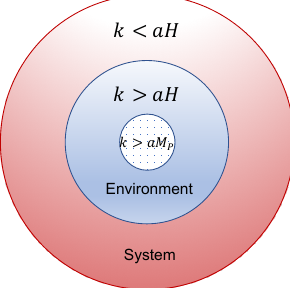
Figure 1. Schematic illustration of the system and environment modes for this setup. Gravity plays the role of providing a natural scale — the comoving Hubble horizon — which demarcates “long” and “short” degrees of freedom (dofs). We impose the Planck mass as the natural cutoff for the UV-modes and assume that these can be properly accounted for within some QG